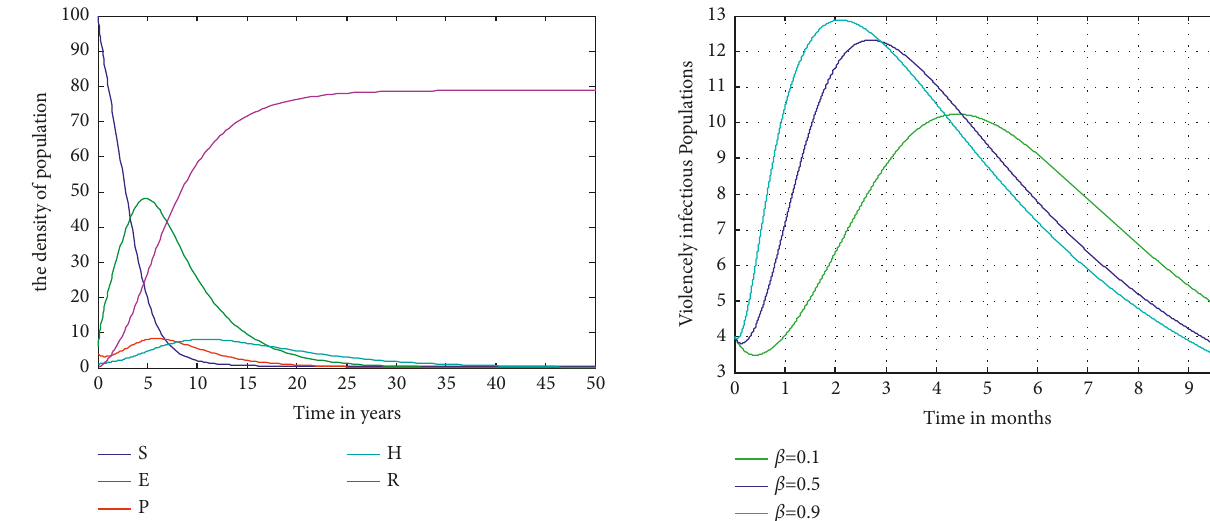
Figure 2: Solutions of model (1) when R